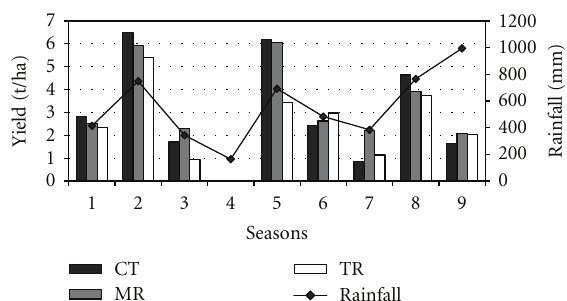
Figure 6: Maize yield under di ff erent tillage systems over nine seasons at Makoholi Contill site.